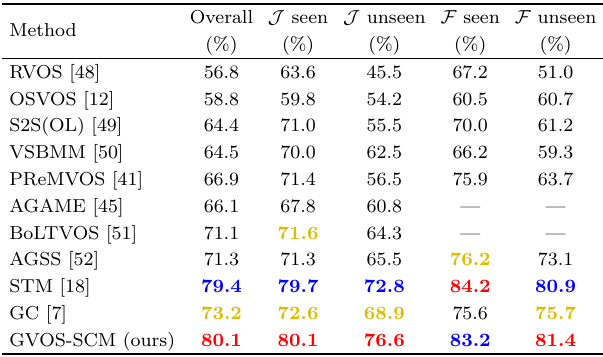
Table 6 Comparison using the YouTube-VOS validation